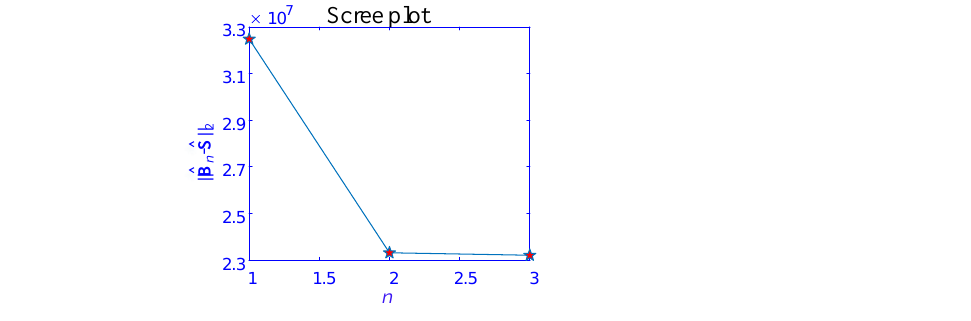
Figure 9. The scree plot of the strain contours of the mechanical simulation sample.